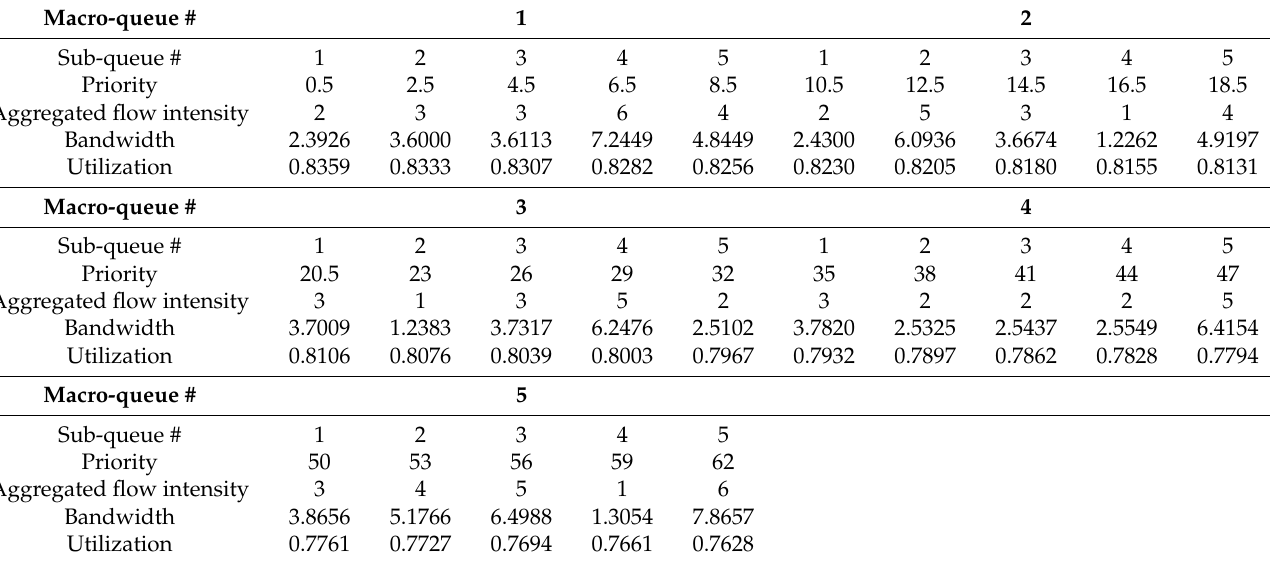
Table 13. The interface bandwidth allocation among the sub-queues of five macro-queues and their